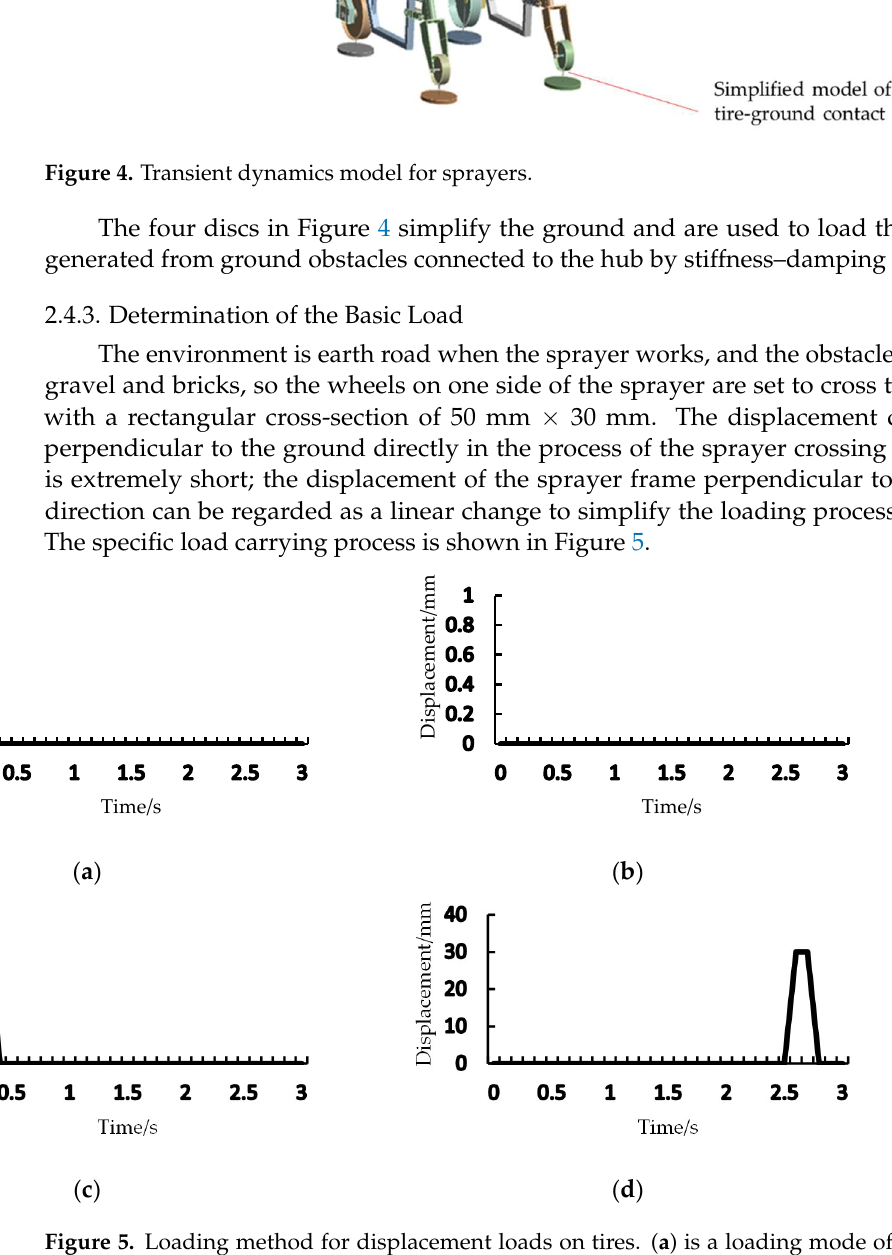
Figure 4. Transient dynamics model for sprayers.